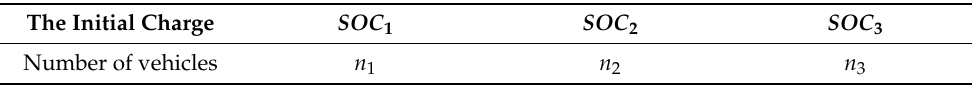
Table 3. Initial charge amount of vehicle charging station